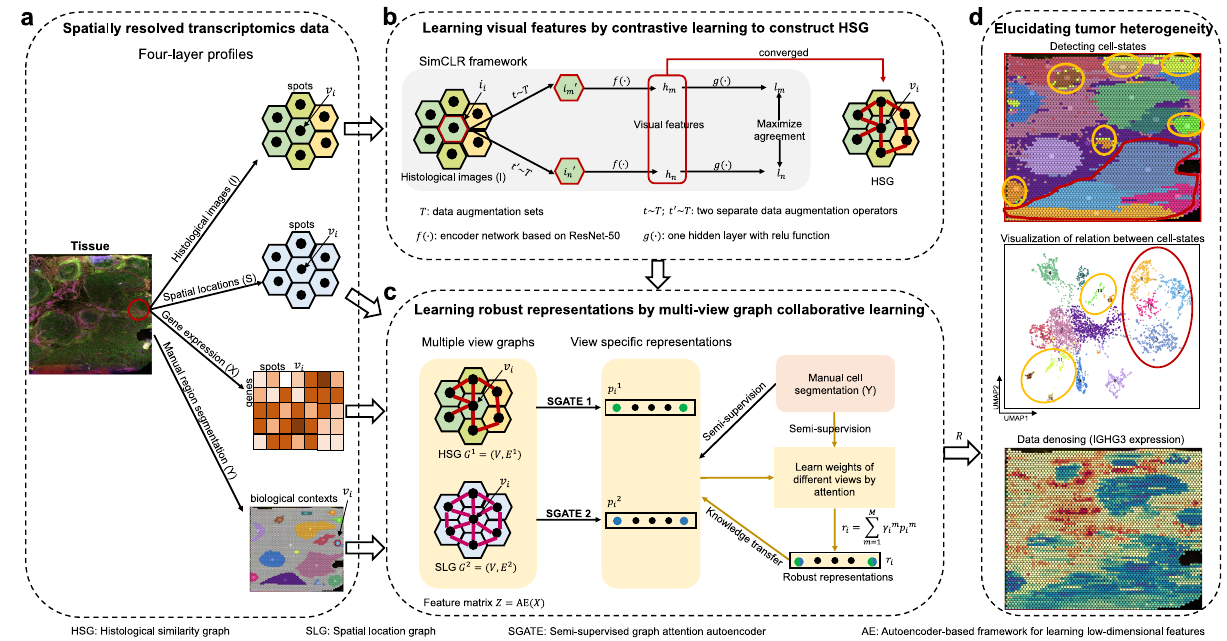
Fig. 1 | Overview of stMVC model. a Given each SRT data with four-layer pro fi les: histologicalimages( I ),spatiallocations( S ),geneexpression( X ),andmanualregion segmentation ( Y ) as the input, stMVC integrates them to disentangle tissue het- erogeneity,particularlyforthetumor. b stMVCadoptsSimCLR modelwith feature extraction framework from ResNet-50 to ef fi ciently learn visual features ( h i ) for each spot ( v i ) by maximizing agreement between differently augmented views of the same spot image ( i i ) via a contrastive loss in the latent space ( l i ), and then constructs HSG by the learned visual features h i . c stMVC model adopting SGATE model learns view-speci fi c representations ( p i 1 and p i 2 ) for each of two graphs